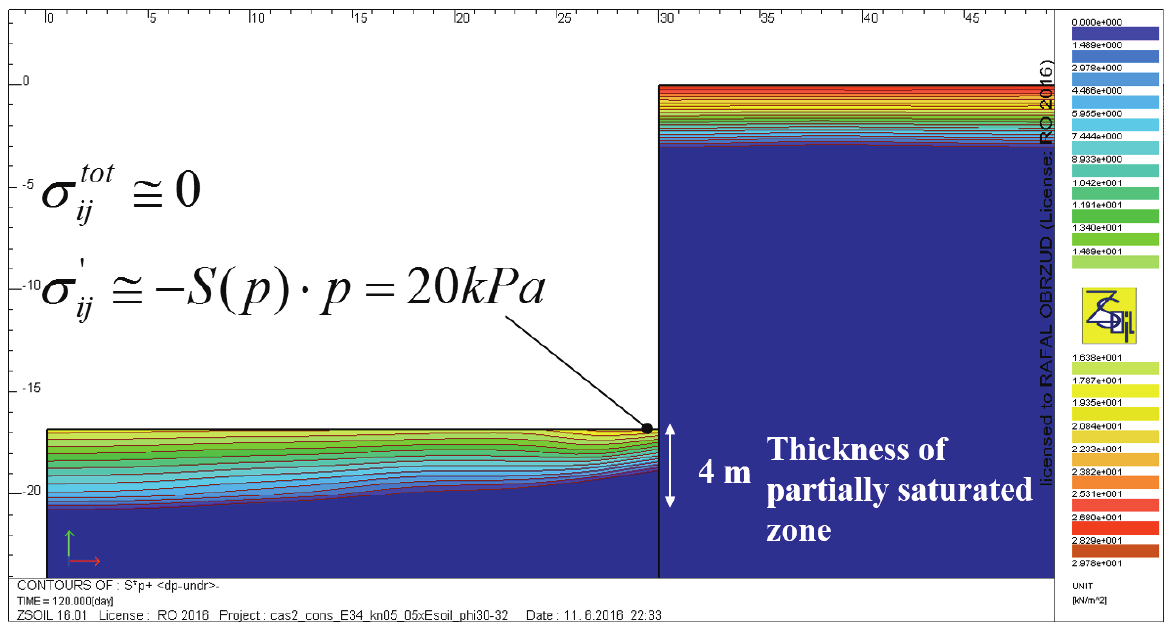
Fig. 16. Suction effect at the bottom of the excavation 30 days after excavation stage